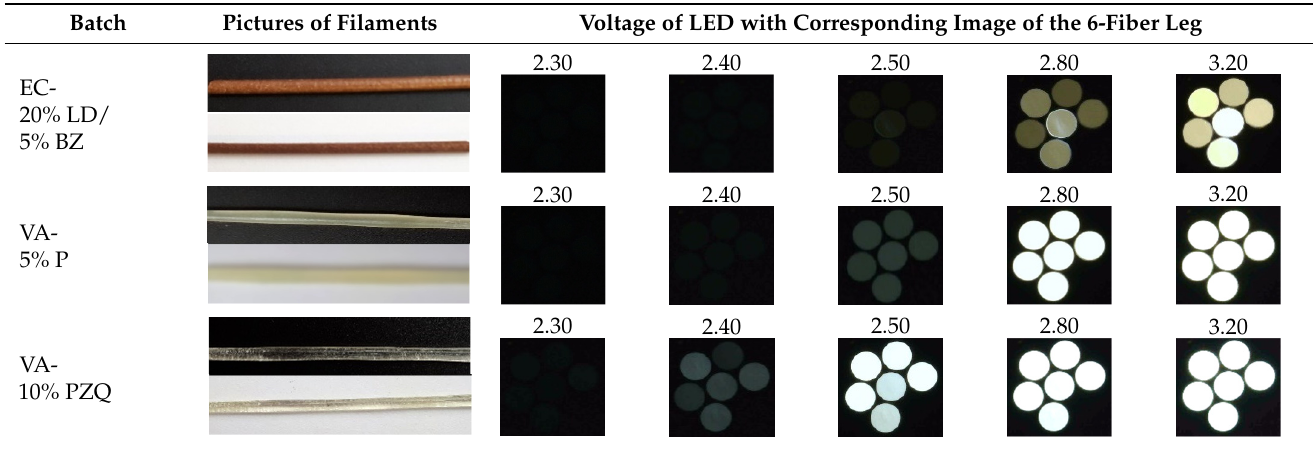
Table 4. Color observation of transmitted light on selected drug loaded filaments.